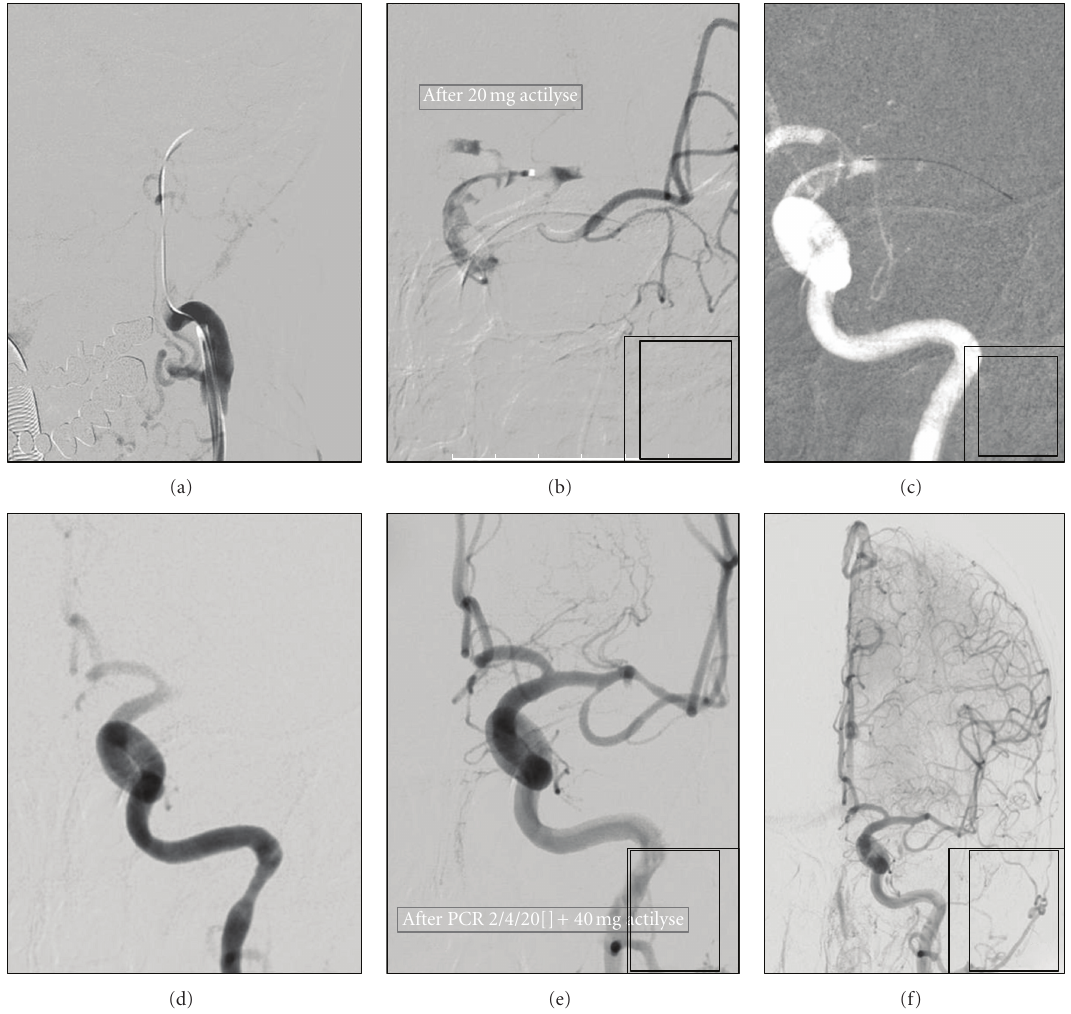
Figure 2: (a) Acute left-sided occlusion of the carotid T; (b) partial recanalization after administration of 20 mg intraarterial rtPA; (c) placement of the pCR 2/4/20 (arrows) in the ACM (M1) distal to the thrombus; (d) recanalization of the carotid T and ACA after retraction of the pCR with thrombus left in the M1 segment; (e) and (f) TICI 2a (TIMI 2) reperfusion after second passage with the pCR and administration of 40 mg intraarterial rtPA collectively. The inferior M2 branch remains